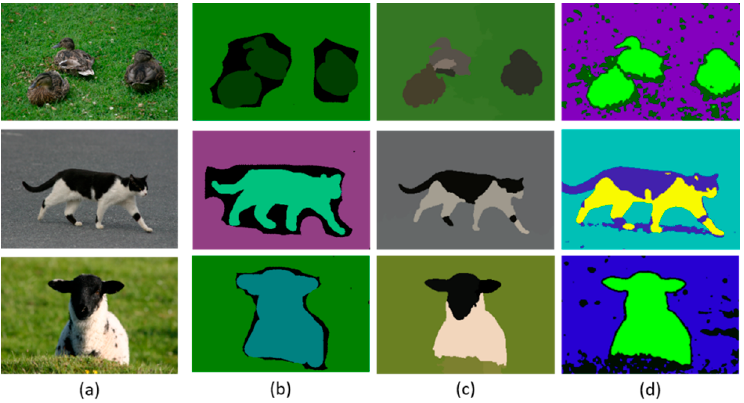
Figure 6. Comparison of objects segmentation examples images; ( a ) original images, ( b ) ground truth ( c ) MFCS results and ( d ) MSS results over MSRC dataset.